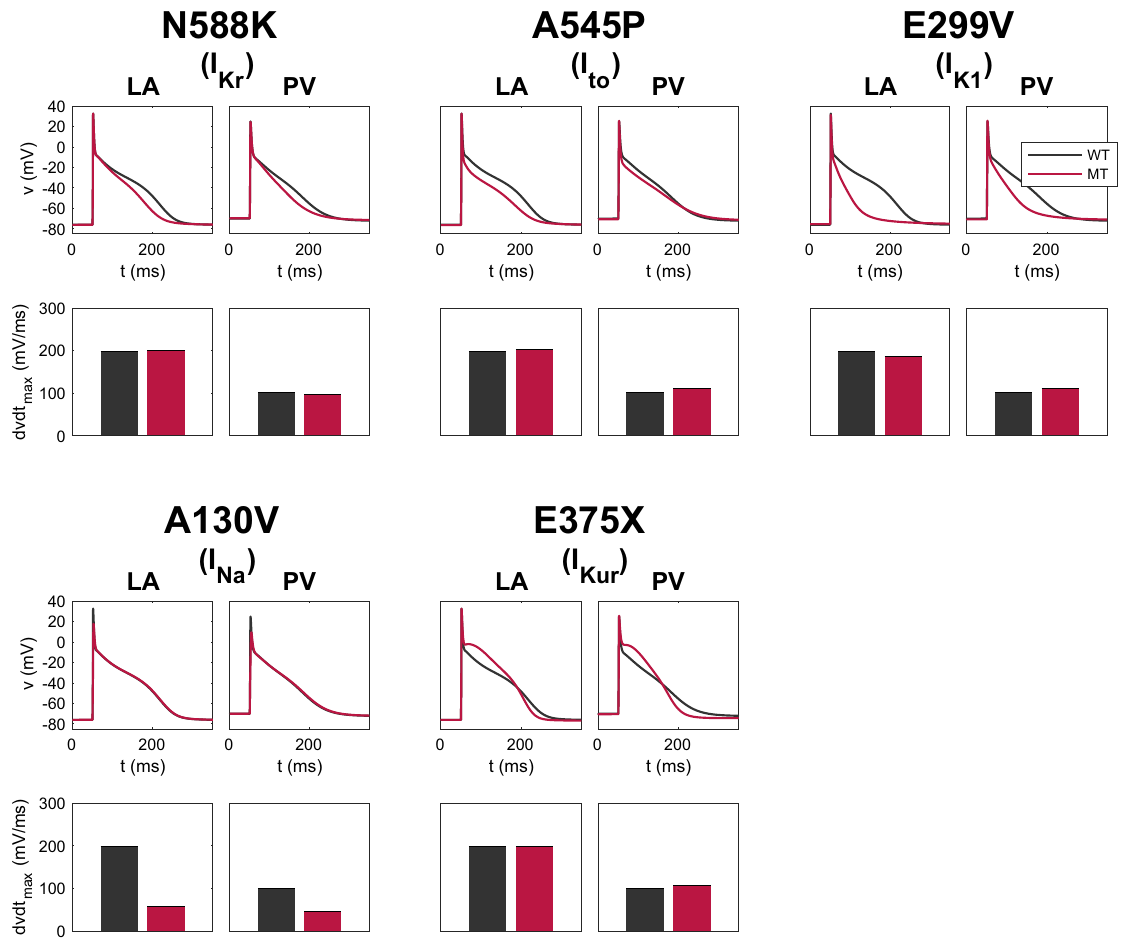
Figure 5. Effects of selected mutations on the AP and maximal upstroke velocity in single myocyte simulations of the LA and PV versions of our membrane model. The black lines and bars refer to WT, and the red lines and bars refer to the mutant cases. Note that the c.932delC mutation (in connexin 43) is not included here because the c.932delC mutation does not affect any of the parameters of the membrane models. However, it can have a significant effect on intercellular coupling, CV and arrhythmogenic substrate in the multicellular (syncytium)